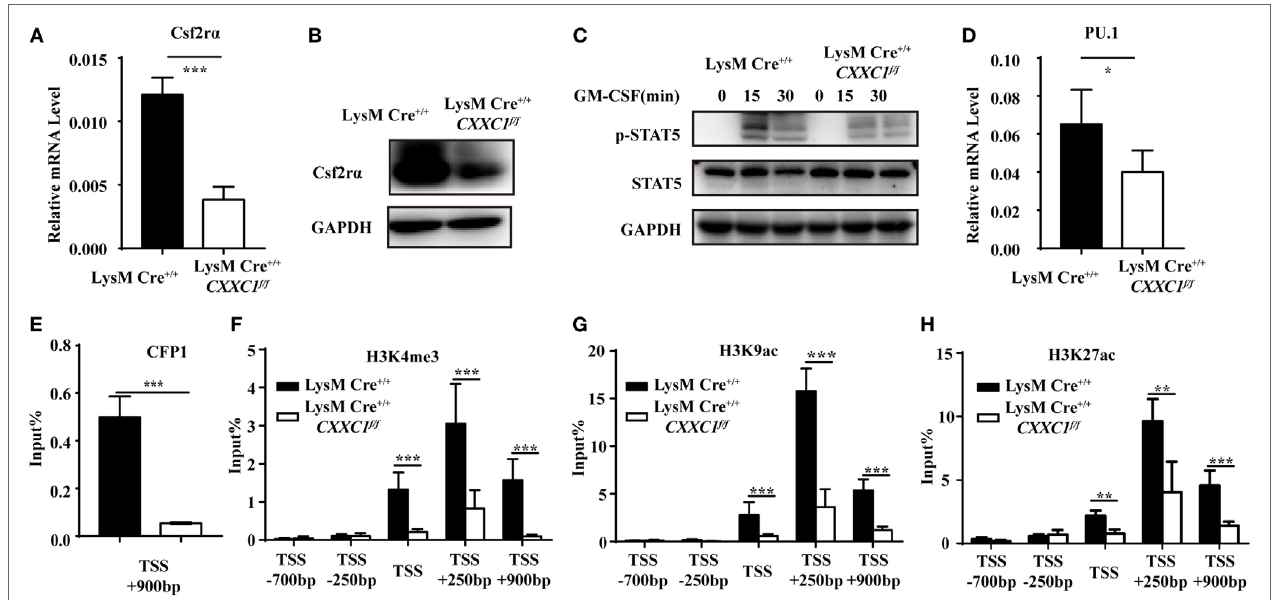
FigUre 4 | Cxxc finger protein 1 (CFP1) bound to the Csf2r α promoter region and was associated with H3K4me3, H3K9ac, and H3K27ac. (a,B) The expression of Csf2r α at the mRNA (a) and protein (B) level in wild-type (black rectangle) and CFP1-deficient (white rectangle) macrophages. (c) Immunoblot analysis of phosphorylated (p-) STAT5 and total STAT5 and GAPDH in wild-type and CFP1-deficient macrophages stimulated for 0–30 min (upper lanes) with GM-CSF (10 ng ml − 1 ). (D) The expression of PU.1 at the mRNA level in wild-type (black rectangle) and CFP1-deficient (white rectangle) macrophages. (e–h) Chromatin immunoprecipitation analysis of endogenous CFP1 (e) , H3K4me3 (F) , H3K9ac (g) , H3K9ac (h) in wild-type (black rectangle) and CFP1-deficient (white rectangle) macrophages, followed by real-time PCR analysis for specific enrichment of each modification at the Csf2r α promoter. The primer positions are relative to the TSS of Csf2r α . The mean and SD of four independent experiments are shown. * P < 0.05, ** P < 0.01 and *** P < 0.001 indicate significant differences between groups as determined by Student’s t